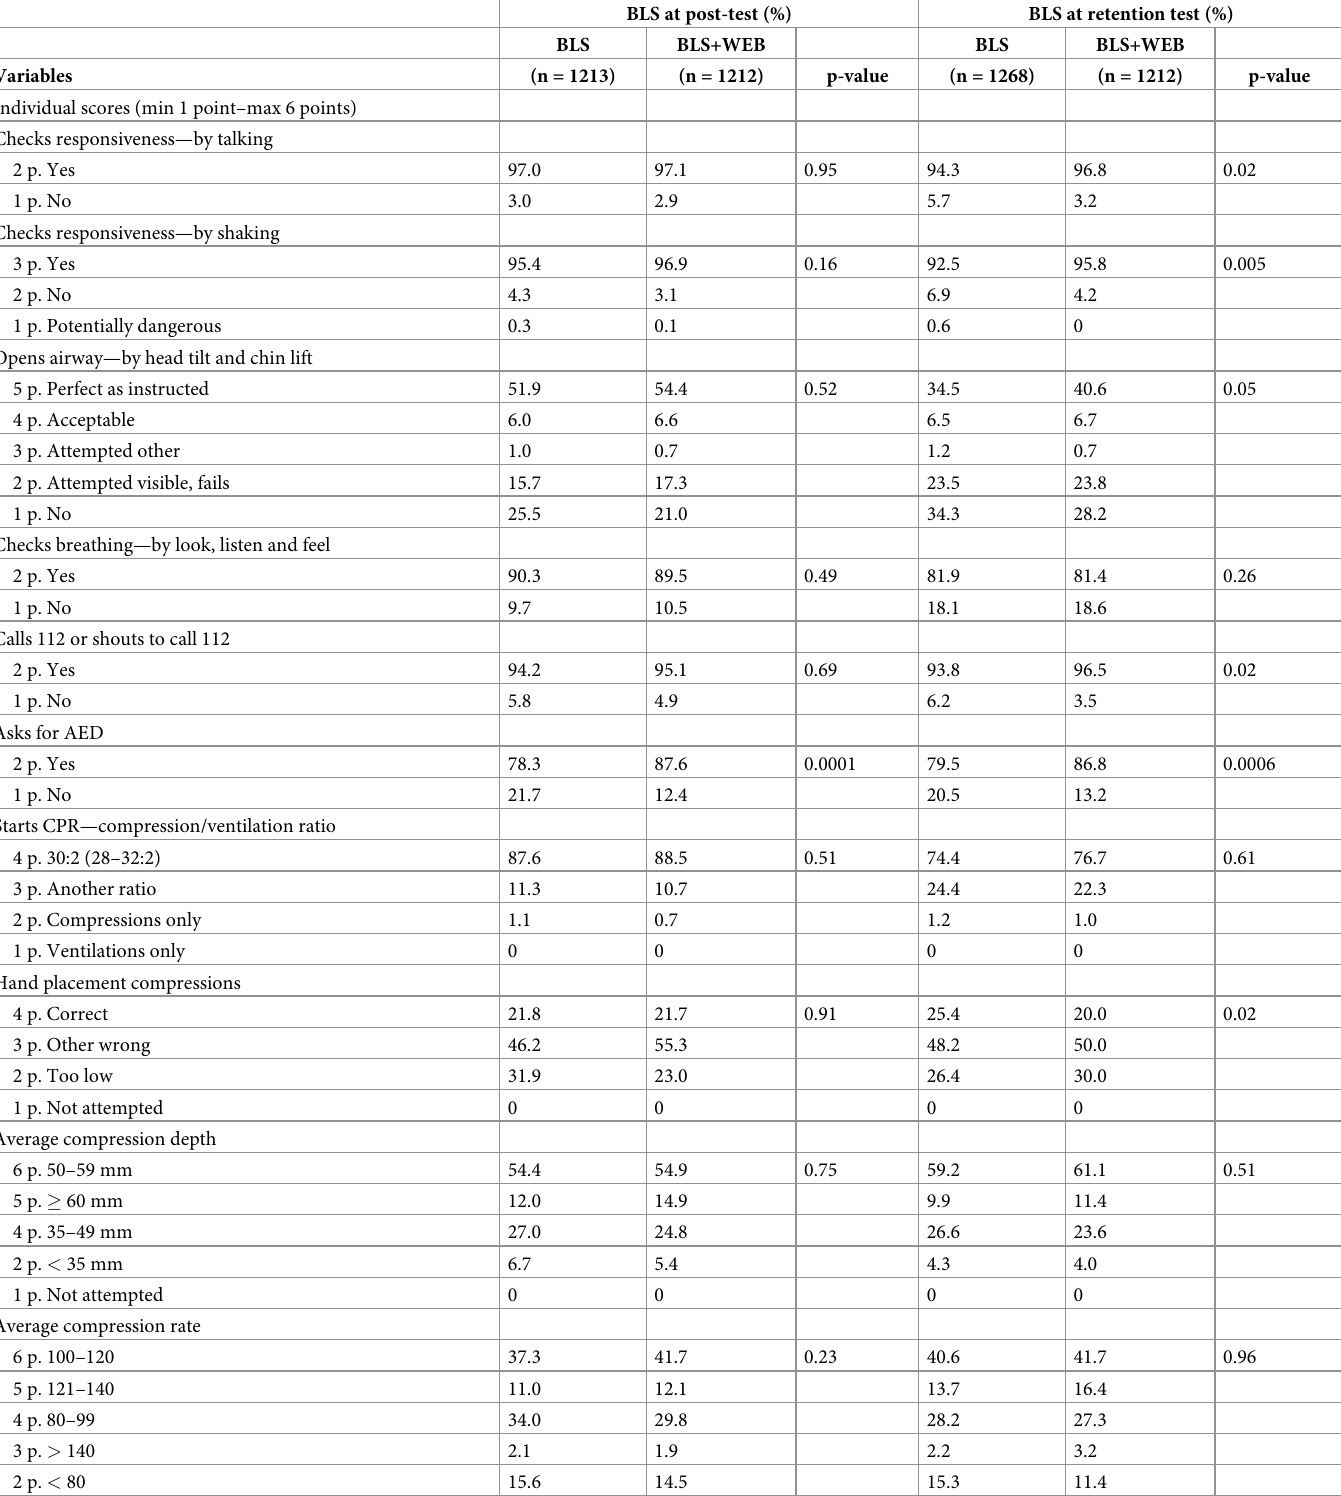
Table 2. Total score on the modified Cardiff Test for adherence to the parameters in the basic life support (BLS)